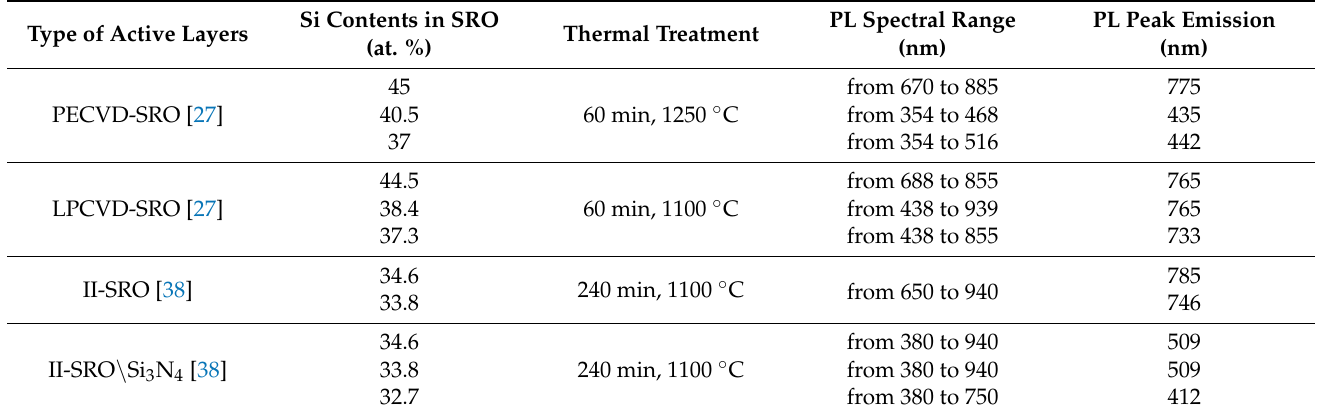
Table 1. Fabrication parameters and characteristics of different SRO films.